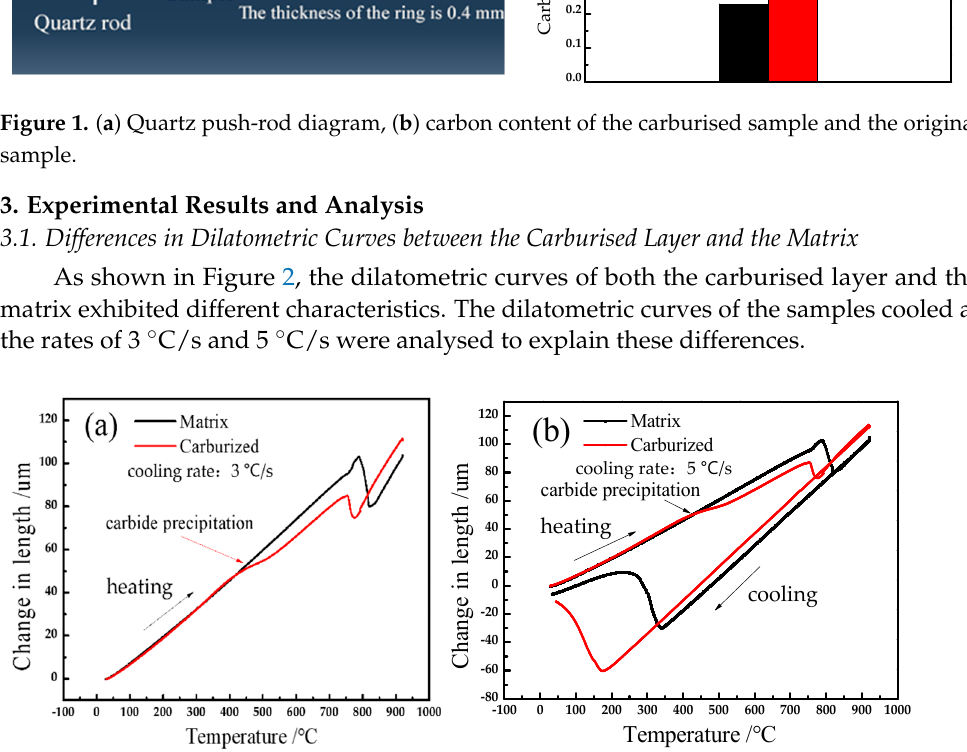
Figure 1. ( a ) Quartz push-rod diagram, ( b ) carbon content of the carburised sample and the original sample.